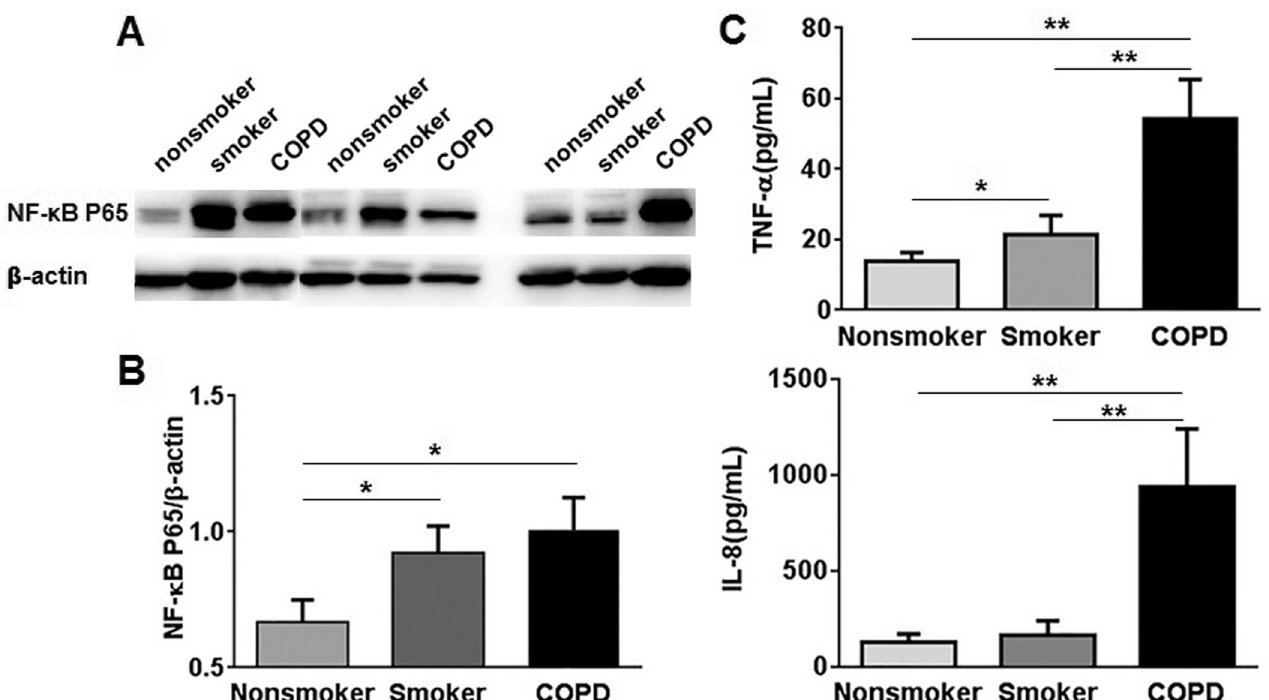
Fig 2. NF- κ B p65 expression in PBMCs and serum cytokine levels in nonsmokers, smokers, and COPD patients. (A) The NF- κ B p65 protein expression was measured by Western blot in the nuclear extracts of PBMCs. β -actin was assessed as a loading control. (B) The relative intensity of NF- κ B p65 was calculated by densitometry. (C) Serum TNF- α level was measured. (D) Serum IL-8 level was measured. Data are presented as mean ± SEM. * P < .05, ** P < .01.